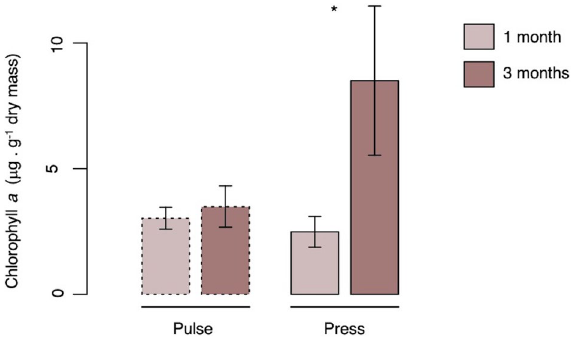
Figure 1. Effect of salinity variation through time on microphytobenthic standing stock. Average chlorophyll a concentration (μg g −1 dry mass) for salinity variation following one and three months of exposure. Pair-wise contrasts showed a significant difference between one and three-months of exposure within for freshwater presses (p < 0.05) as indicated by the asterisk. Histograms represent mean values, and error bars correspond to standard errors.